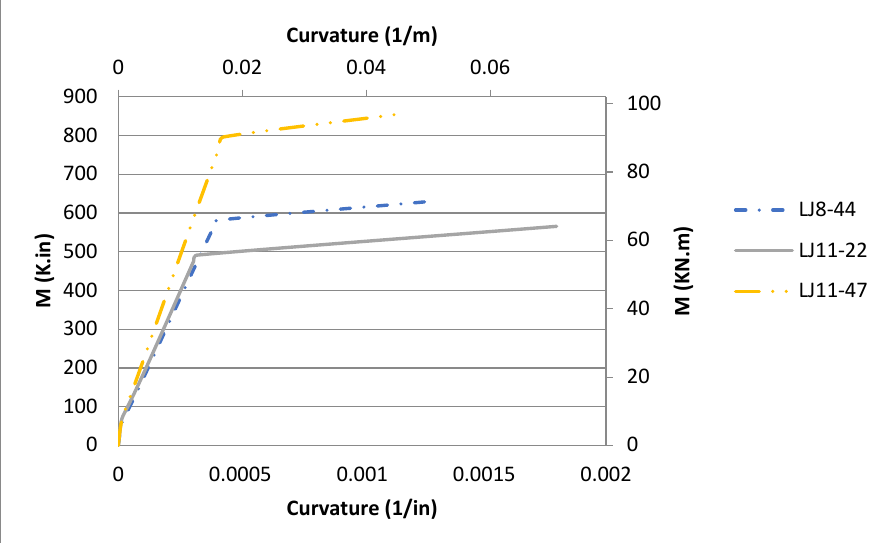
Figure 17. Ahmad and Batts (1991) [17] moment vs. maximum compressive strain analytical graphs. Simplified Non-Linear Sectional and Beam Analysis All previous comparisons showed a good agreement with the experimental data in terms of the global response of the beams. In this section, a detailed comparison is pre- sented against two beams tested by Decker (2007) [18] and Almusallam (1997) [19]. Decker reported the global and sectional responses in his work. The sectional response was ob- tained by locating strain gauges at the tensile steel level and the top surface of the beam, which allowed for a full strain profile development. Unfortunately, Decker (2007) [18] re- ported the failure of the strain gauges in the post-yielding zone. The beams were simply supported and were tested in four-point bending. The supports were placed 3 inches from the edge of the beam, providing a clear span of 4.72 m (15.5 ft). Tables 4 and 5 show the